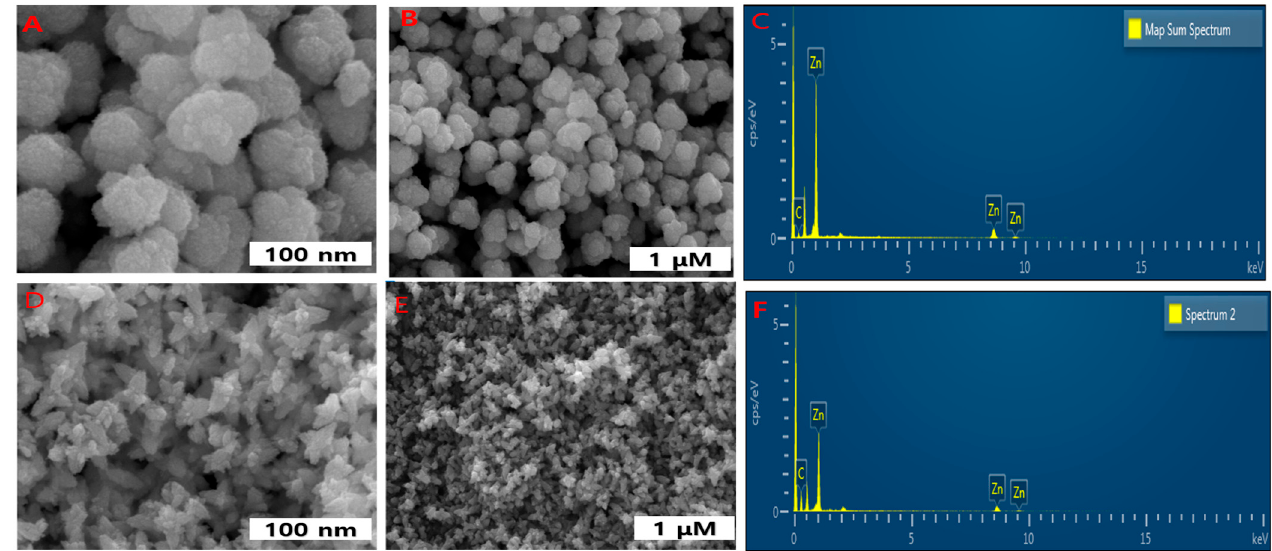
Figure 7. FE-SEM analysis of DM-ZnO nanoparticles exhibited spheroid shape in ( A , B ) and DM-ZnO-Try nanoemulsion exhibited flower shape in ( D , E ). EDS analysis for DM-ZnO-NPs ( C ) and DM-ZnO-Try-NE ( F ).